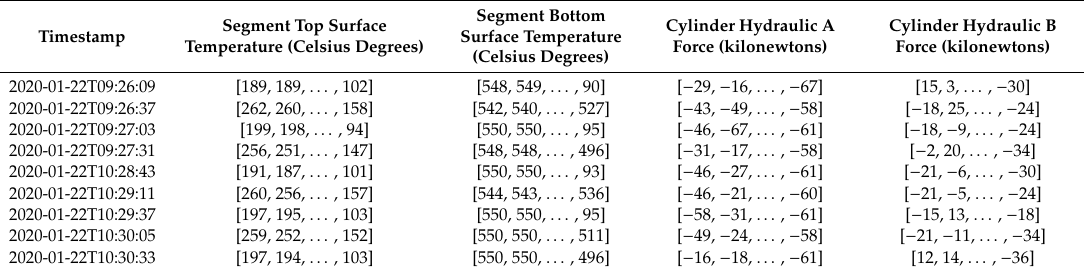
Table 2. A dataset